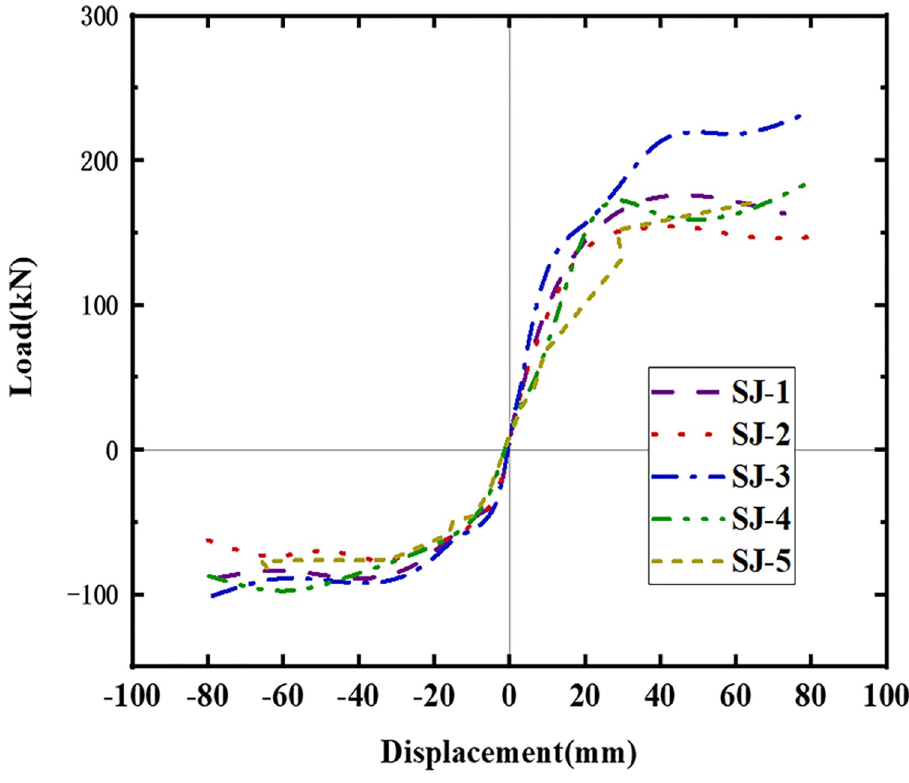
Fig 21. Skeleton curves of five specimens.